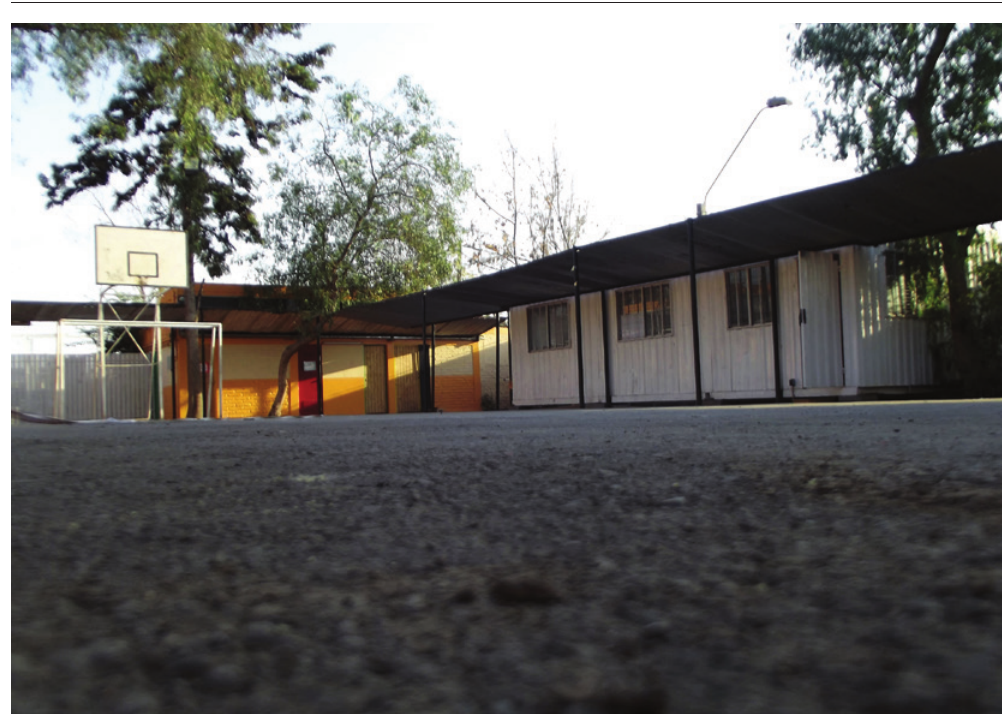
Figure 2: Choosing an empty